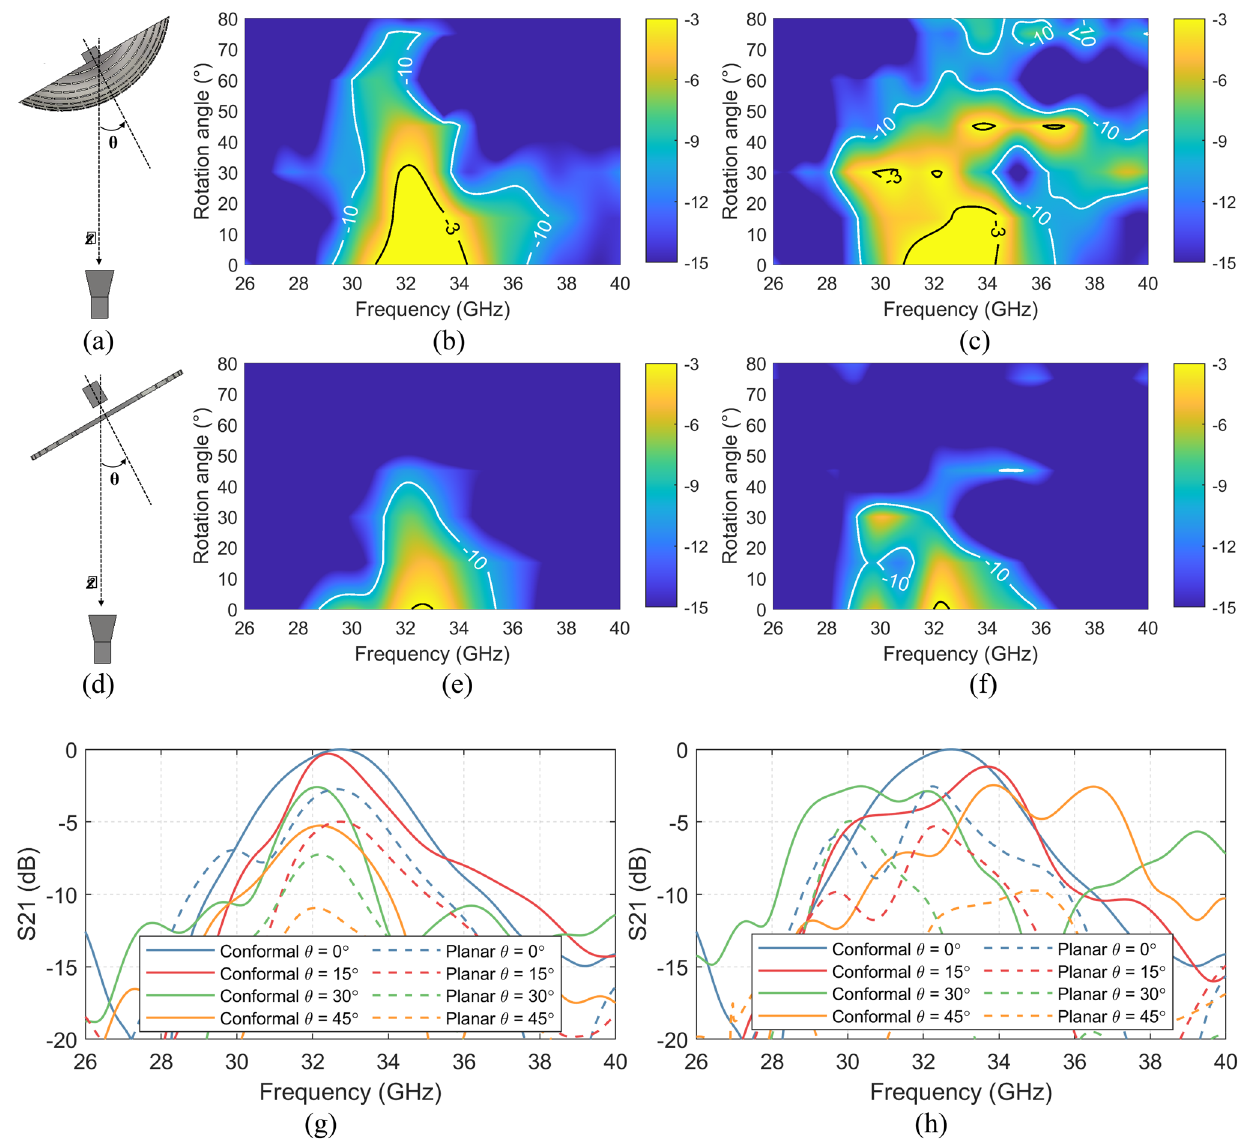
Figure. 5. (a) Set up of conformal FSSs for different rotation angles along XZ plane; (b) simulated S21 results with the TE polarized incidence of the conformal FSS; (c) simulated S21 results with the TM polarized incidence of the conformal FSS; (d) set up of planar FSS for different rotation angles along XZ plane; (e) simulated S21 results with the TE polarized incidence of the planar FSS; (f) simulated S21 results with the TM polarized incidence of the planar FSS; (g) comparison between selective simulated S21 results of conformal FSS and planar FSS with the TE polarized incidence; and (h) with the TM polarized support structures were strategically chosen to ensure the overhanging parts of the FSS being fabricated correctly. Parameters including the support spacing, the distance between the supports and the main printed structure, support density, cooling speed were adjusted to provide the balance between good support yet could be easily removed, so that no remains stuck on the FSS and thus surface smoothness was improved. Furthermore, the supports density was locally tailored so that the supports did not affect the dimensions of the FSS slots. Two imperfect manufactured samples are presented in Fig. 6(a) and (b). Figure 6(a) corresponds to printing the structure with the convex face down, showing that the top face could not be properly filled. On the other hand, when the structure was printed face up as a dome but with no support, it resulted in the poor surface texture of the inner convex face (see Fig. 6(b)). After several adjustments to the printing parameters and FSS arrangements, it was concluded that the best results were obtained when printing the FSS face up using support structures, whose parameters have been meticulously adjusted (see Fig. 6(c)). Some of the most critical parameters for the proposed FSS were: layer height = 0.1 mm, material infill = 10%, support enabled, support infill = 15%, support z distance = 0.15 mm, tow- ers enabled, tower diameter = 2 mm, heat plate = 40 ºC, nozzle temperature = 210 ºC, fan speed = 100%, initial fan speed = 0%, regular fan speed at layer = 10. By using the optimal parameters, a smooth surface was obtained